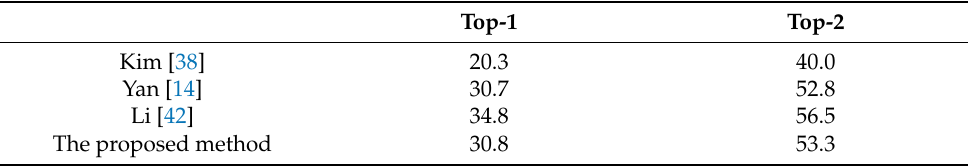
Table 5. The accuracy performance with the Kinetics dataset